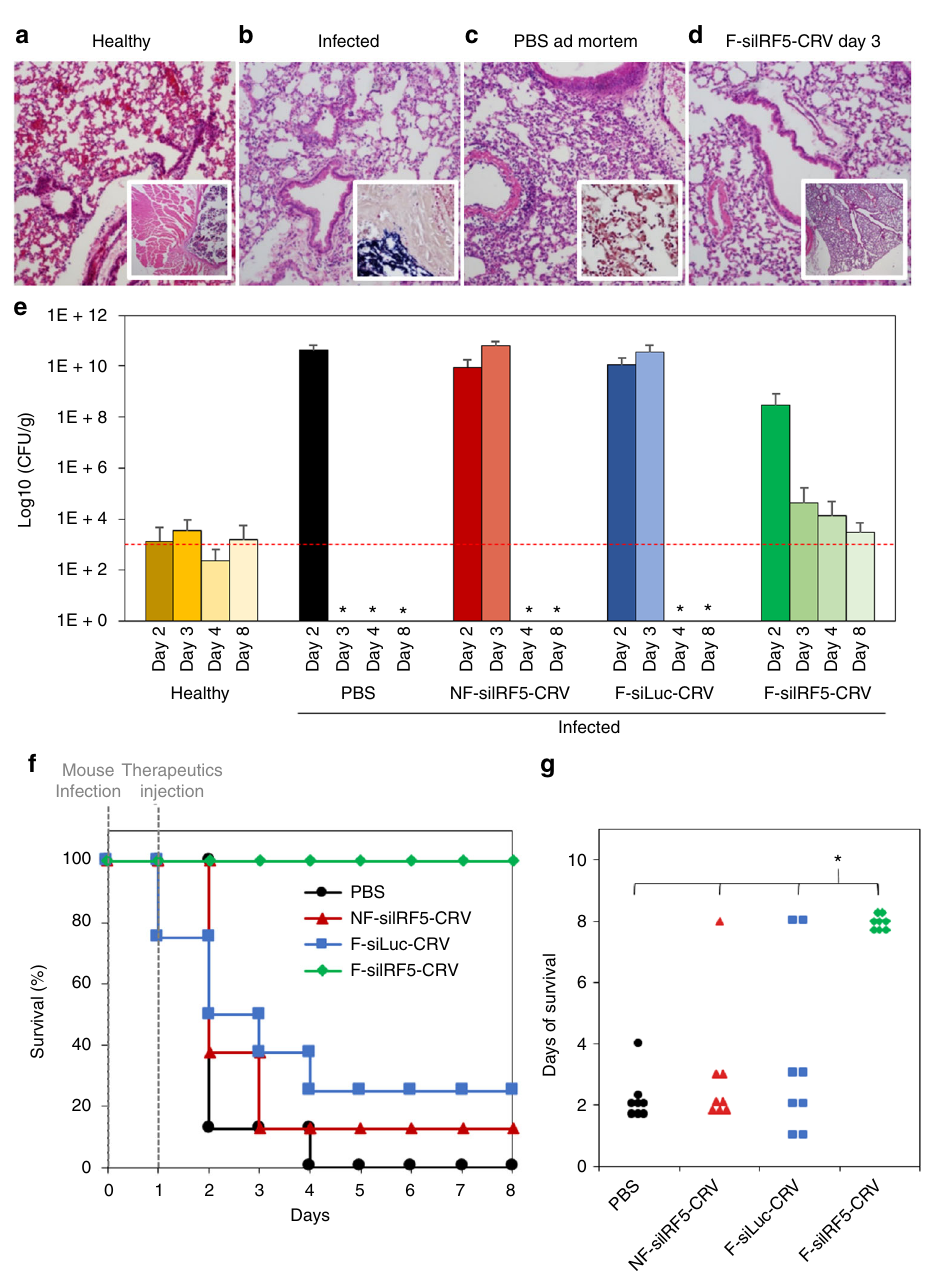
Fig. 5 Macrophage-targeting fusogenic pSi nanoparticles loaded with si Irf5 effectively treats infected mice. a – d H&E-stained sections of Balb/C mouse lungs subjected to histopathological analyses. a Lung of healthy mouse with no treatment (inset shows lower magni fi cation of the same). b Lung of infected mouse with no treatment (inset shows large population of S. aureus in the perilaryngeal muscle). c Lung of infected mouse ad mortem 24 h post-PBS treatment (inset shows gram stain of S. aureus populations in the lung); d Lung of infected mouse treated with F-siIRF5-CRV nano-therapeutic (administered at 23.2 µ mol/kg lipid, 24 µ g/kg siRNA, 0.5 mg/kg pSi) at 3 days post treatment (inset shows lower magni fi cation of the same). e Bacterial titer from lungs of healthy and infected mice injected with PBS, NF-siIRF5-CRV (non-fusogenic, targeted nanoparticle containing si Irf5 therapeutic), F-siLuc- CRV (fusogenic, targeted nanoparticle containing siRNA against luciferase, as a negative control for si Irf5 ), and F-siIRF5-CRV (fusogenic, targeted nanoparticle containing si Irf5 therapeutic). Animals were infected on day 0 and therapeutic or control injections were given on day 1. The dashed red line indicates the average count of colony-forming units (CFU) in healthy mouse lungs. Error bars indicate SD. Each bar represents n = 8 animals. *Ad mortem; no measurements due to death of all mice in the cohort. f Mouse survival post-infection (at day 0) and post-therapeutic injection (at day 1) of PBS, NF- siIRF5-CRV, F-siLuc-CRV, or F-siIRF5-CRV. Each group has n = 8 mice. g Average days of survival of mice from f post-infection and post-therapeutic injection. One-way ANOVA with Tukey ’ s HSD post hoc test ( p -level< 0.05, F (3, 28) = 17, p = 1.77 × 10 − 6 ) revealed signi fi cant difference between F- siIRF5-CRV therapeutic and remaining three groups (PBS, NF-siIRF5-CRV, and F-siLuc-CRV). All animal experiments were performed independent of each other with different cohorts of